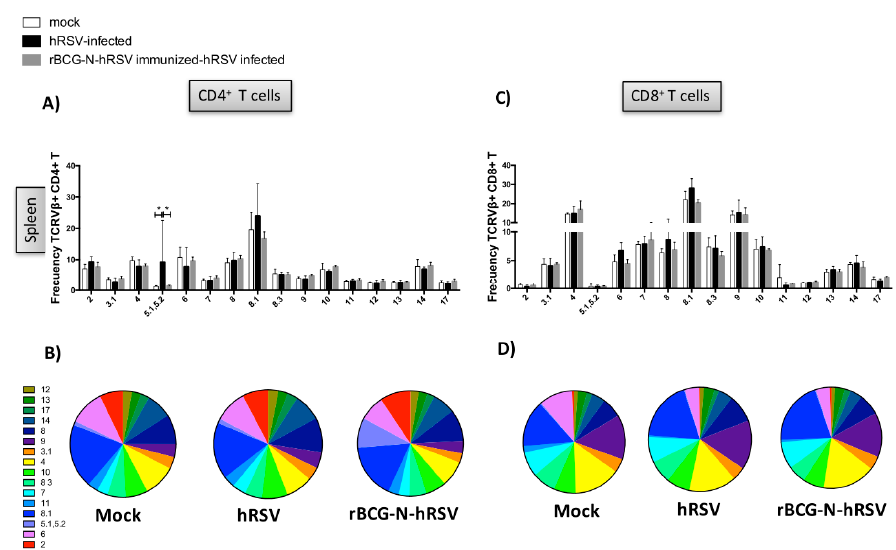
Figure 4. TCRV β + expression in the CD4 + and CD8 + T cells in spleen in the context of infection and immunization. BALB/cJ mice were immunized with rBCG-N-hRSV and 14 days postimmunization were infected with 1 × 10 6 PFU of hRSV. Four days after infection, mice were euthanized. The spleens of mice sacrificed at seventh day postinfection were collected, and the resulting splenocytes were then stimulated with heat-inactivated hRSV (HI-hRSV) (57 ◦ C for 30 min). Seventy-two days poststimulation, the expression of different TCRV β + was evaluated by flow cytometry in rBCG-N-hRSV immunized and hRSV-infected mice. The expression of different TCRV β + was evaluated by flow cytometry in rBCG-N-hRSV immunized and hRSV-infected mice in CD4 + and CD8 + T cells. Frequencies are shown in bars ( A , C ) and in pie charts ( B , D ). The differences between TCRV β + expression among the different experimental groups were determined using multiple t -students tests, * p < 0.05. Bars represent mean ± SD in all